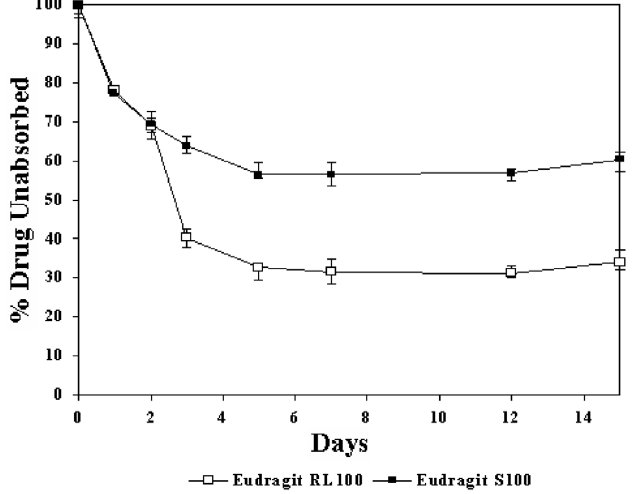
FIGURE 2 - Adsorption pattern of PHC onto RL100 and S100 Particles from pH 7.4 Phosphate